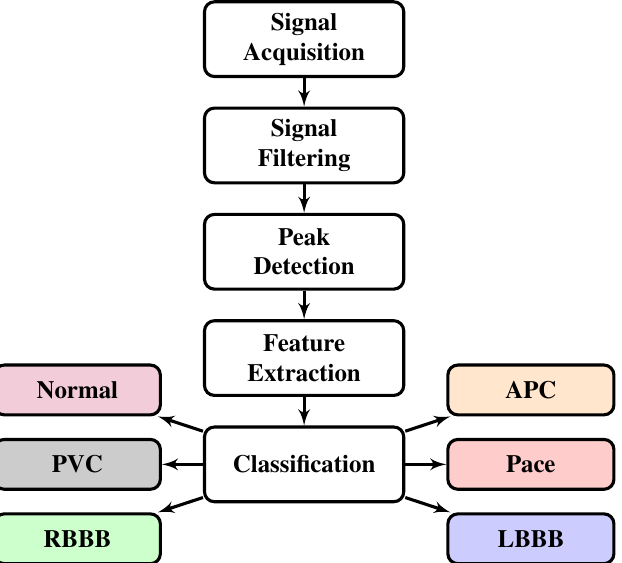
Figure 3. Block diagram of the proposed methodology, [ PVC: Premature ventricular contraction, RBBB: Right bundle branch block, APC: Atrial premature contraction, LBBB: Left bundle branch